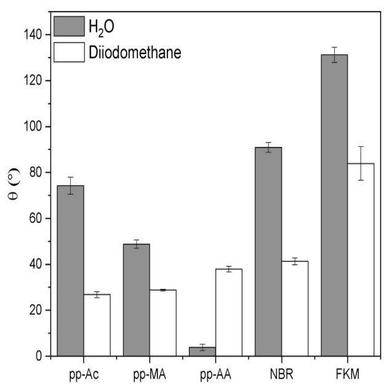
Contact angle of water or diiomethane drops on pp-Ac, pp-AA, pp-MA, NBR and FKM.